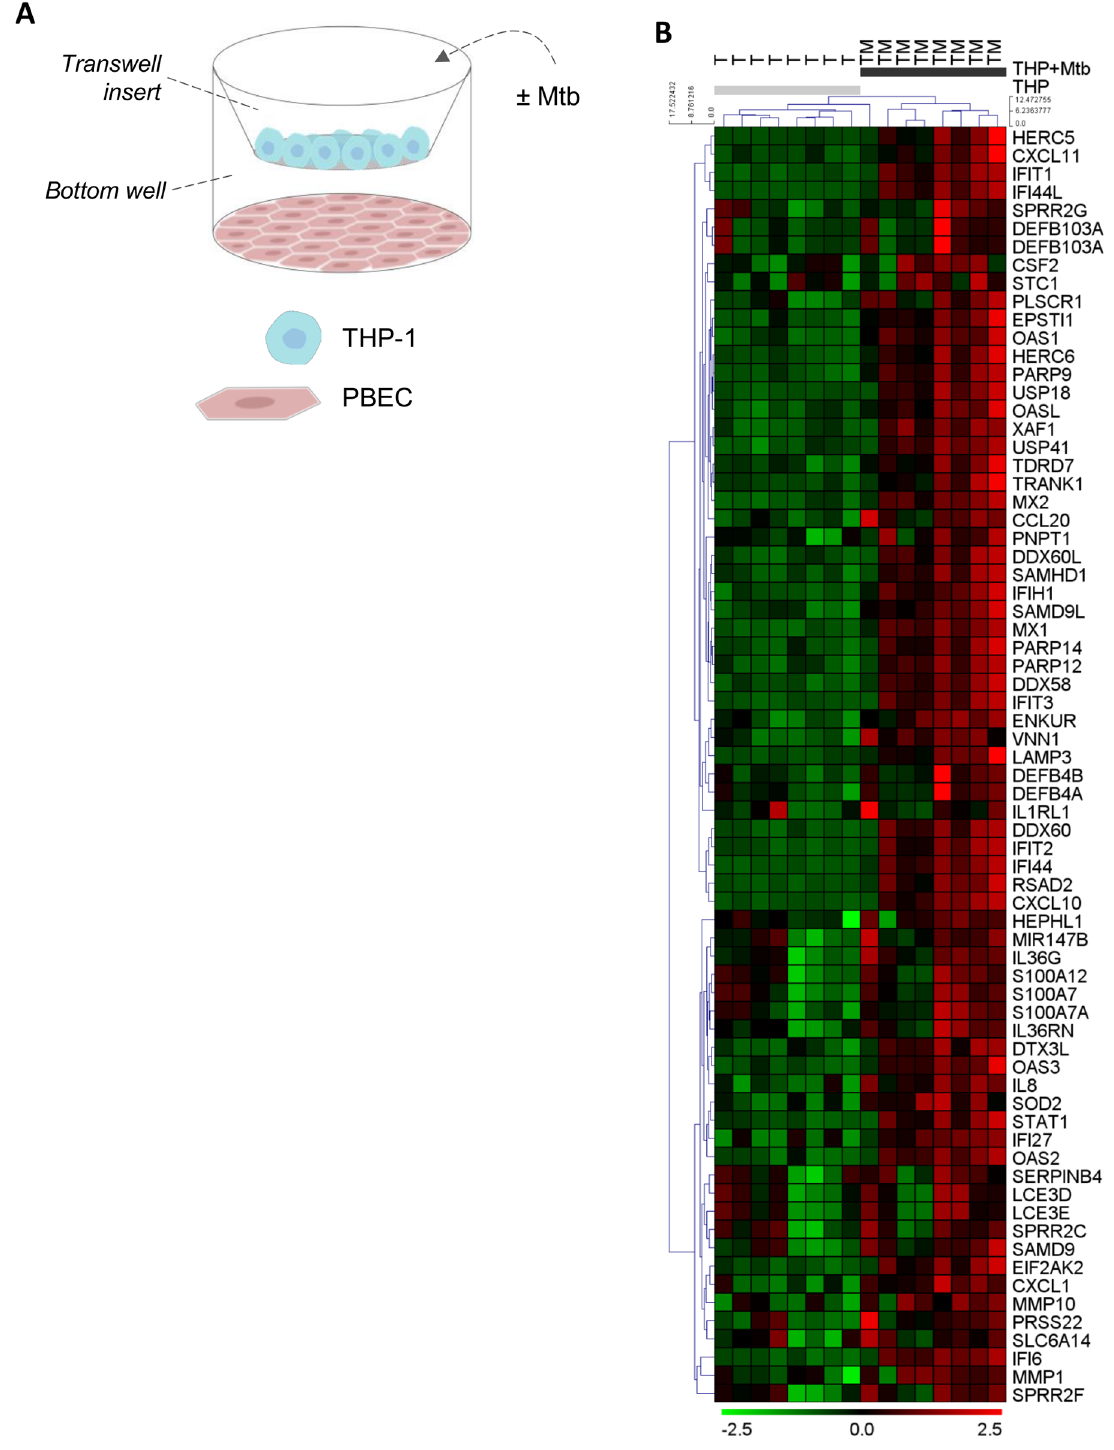
Fig 2. Whole transcriptome analysis of PBECs exposed to Mtb-infected myeloid cells. (A) To interrogatethe effect of myeloid-epithelial cross-talk during Mtb infection, a transwellco-culture system was established. Separatedby a 0.4 μ m pore- sized transwellmembraneto allowexchangeof solublemediatoronly, PBECs were seeded in the bottom well of a tissue culture plate and THP-1 cells were added into the transwellinsert. Cells were infected as indicated.(B) In the transwellco-culture model, PBECs from eight donors were exposedto uninfected(THP, T) or Mtb-infectedTHP-1 (THP + Mtb, TM) cells for 24h.